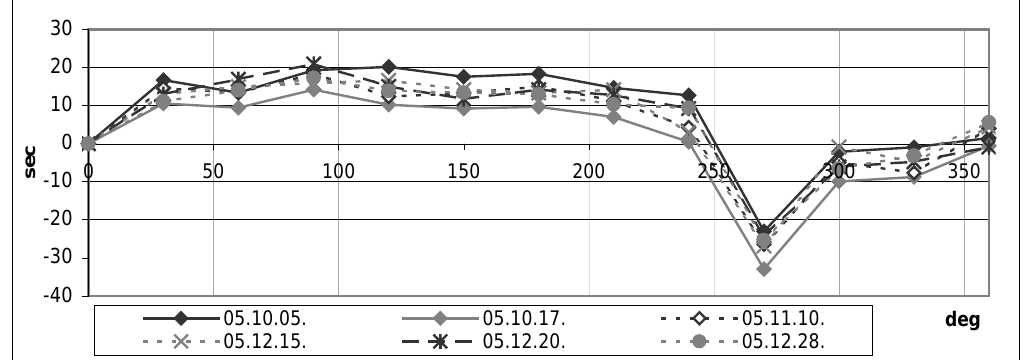
Fig 2 . Graphs of readings of the photoelectric microscope (different dates)